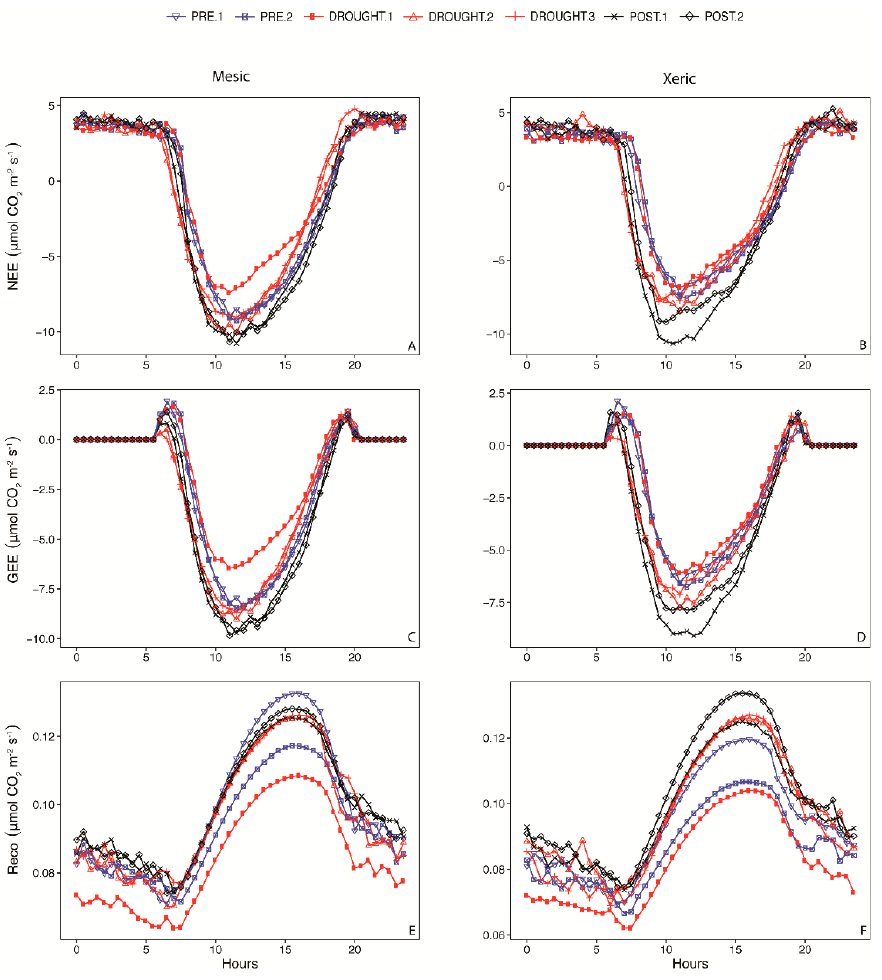
Figure 1. NEE, GEE, and R eco seasonal diurnal diel curves in the mesic site (panels ( A ), ( C ), and ( E ), respectively) versus xeric site. (panels ( B ), ( D ), and ( F ), respectively).